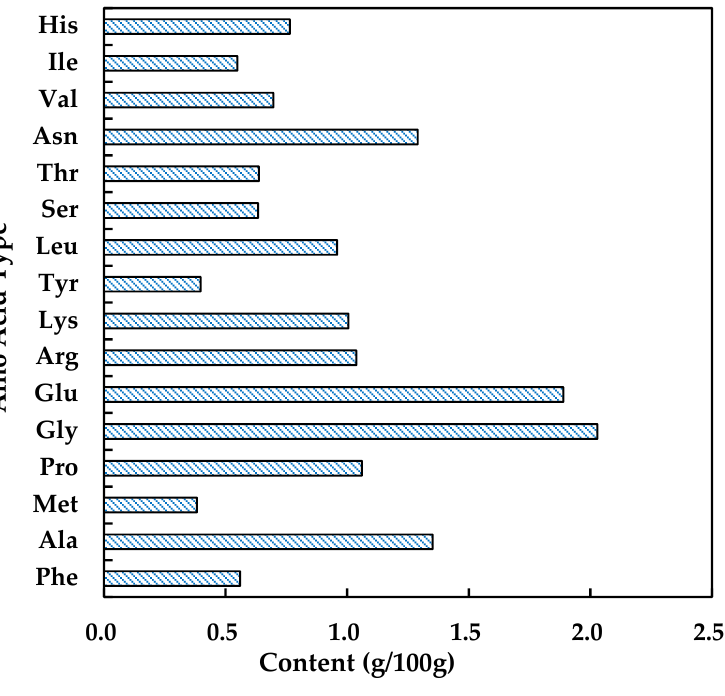
Figure 1. Composition of amino acid in tuna waste-based peptone after hydrolysis.